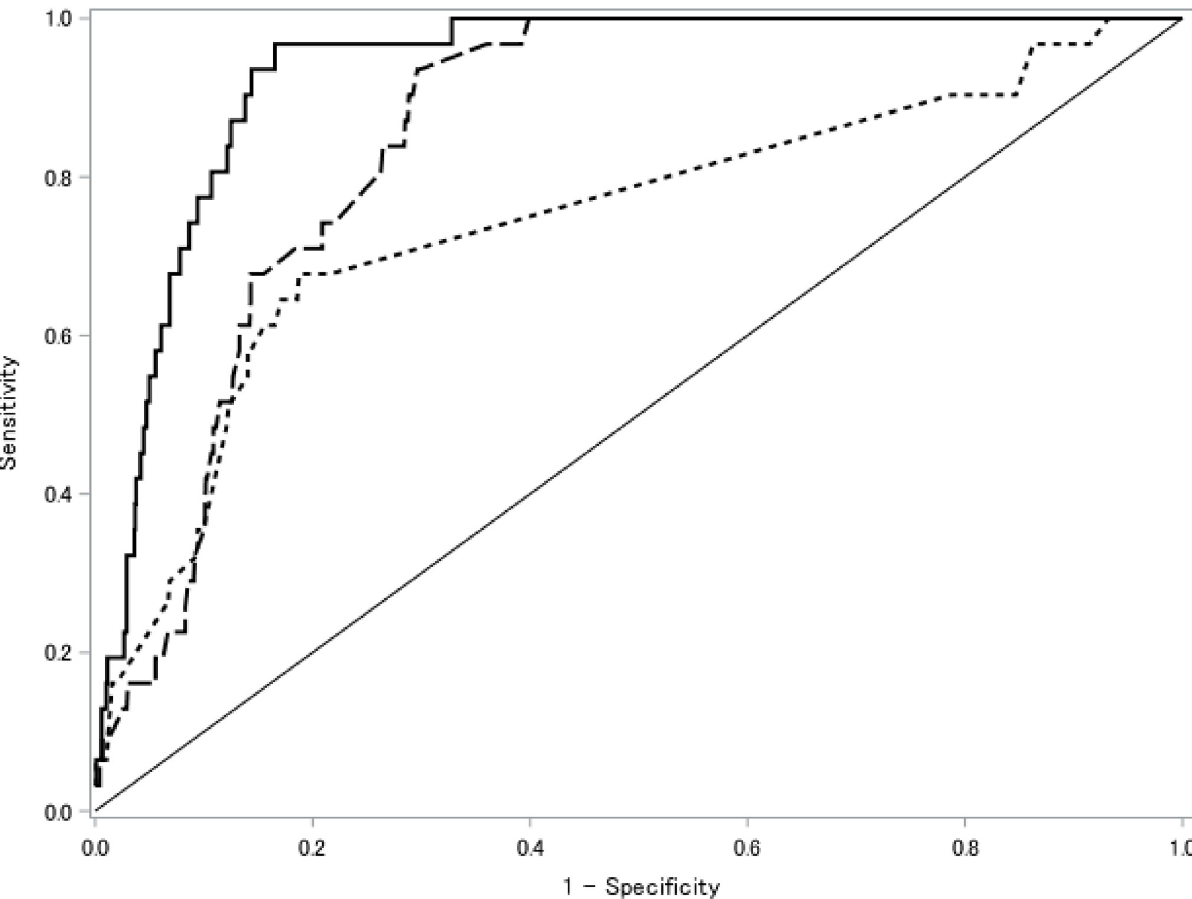
Fig 2. Receiver operating curve for prediction of mechanical ventilation use by changes in oxygen demand. Changes in oxygen demand to predict MV use within 12 h were evaluated by ROCs in several models as follows: simple model only using increments in oxygen demand (AUC 0.756 [0.662– 0.851]); combination model using both amounts and increments in oxygen demand (AUC 0.888 [0.856–0.919]); and a fully adjusted model including amounts and increments in oxygen demand, RR, Ct value of PCR for SARS-CoV-2, and days from positive PCR (0.933 [0.908–0.958]). Abbreviations: ROC, Receiver operating curve; MV, mechanical ventilation; AUC, area under the ROC; RR, respiratory rate; Ct, quantification cycle; PCR, polymerase chain reaction; and SARS-CoV-2, severe acute respiratory syndrome coronavirus 2.